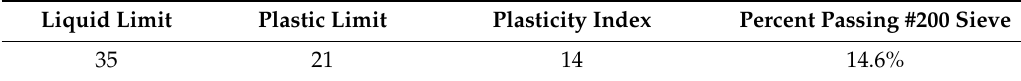
Table 2. Clayey soil physical